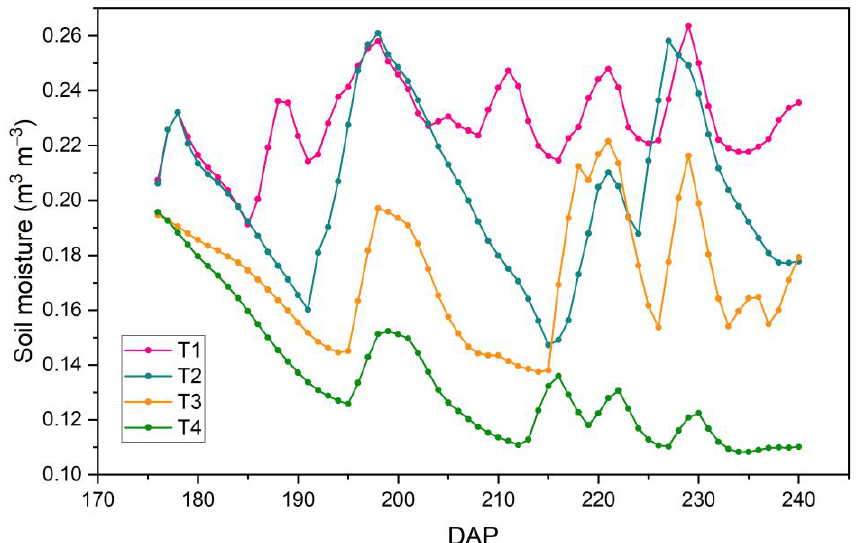
Figure 6. Seasonal variation of soil moisture under different water stresses. The soil moisture was represented by the average soil moisture at depths of 10, 20 and 50 cm. DAP means days after planting.